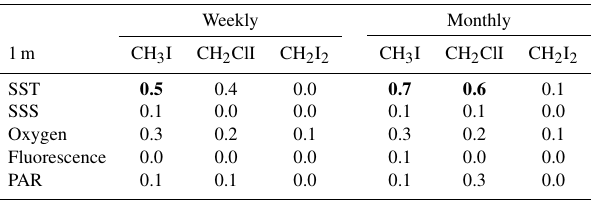
Table 2. R 2 value (Pearson’s correlation coefficients, p < 0 . 05) for iodocarbons and potentially relevant parameters based on both weekly data and monthly average. The significant correlations are highlighted with bold